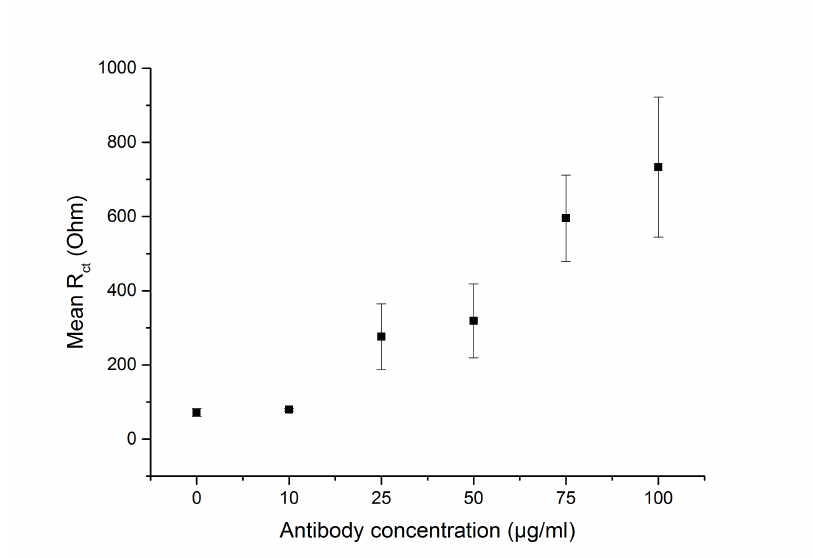
Figure 2. An EIS measurements to test the optimal antibody concentration (0, 10, 25, 50, 75 and 100 µ g/mL) to cover the electrodes surface. The charge transfer resistance was extracted from the measured Nyquist plots and plotted against each antibody concentration. The highest charge transfer resistance was measured for 100 µ g/mL and used for further